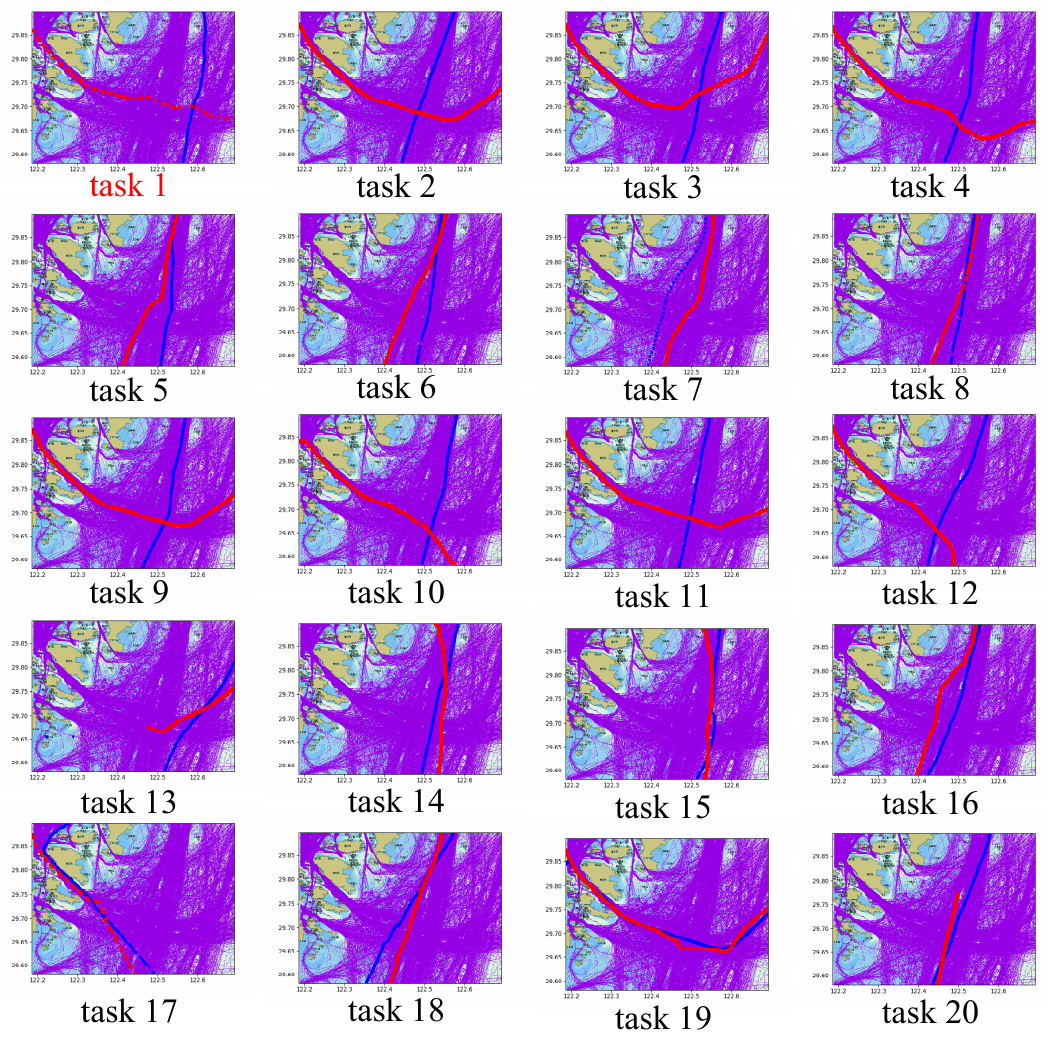
Figure 17. Training data extracted from the AIS data.